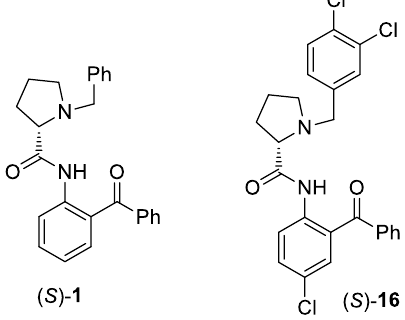
Figure 1. Chiral tridentate ligands.